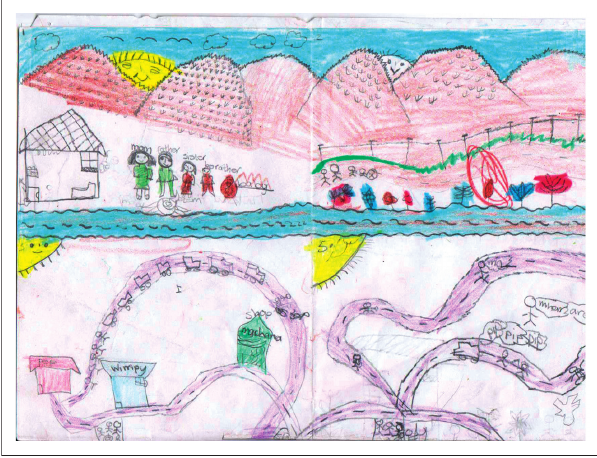
FIGURE 2: Thinking visually: Frames 1–4 of Sikelewa’s storyboard.